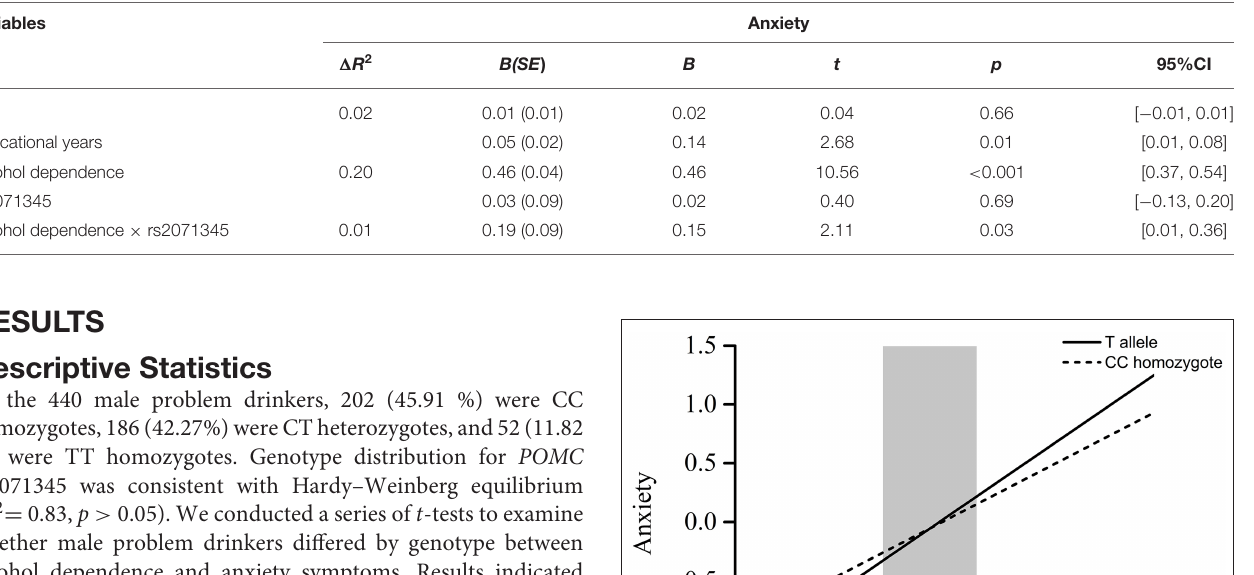
TABLE 2 | Interaction between POMC rs2071345 and alcohol dependence on anxiety.